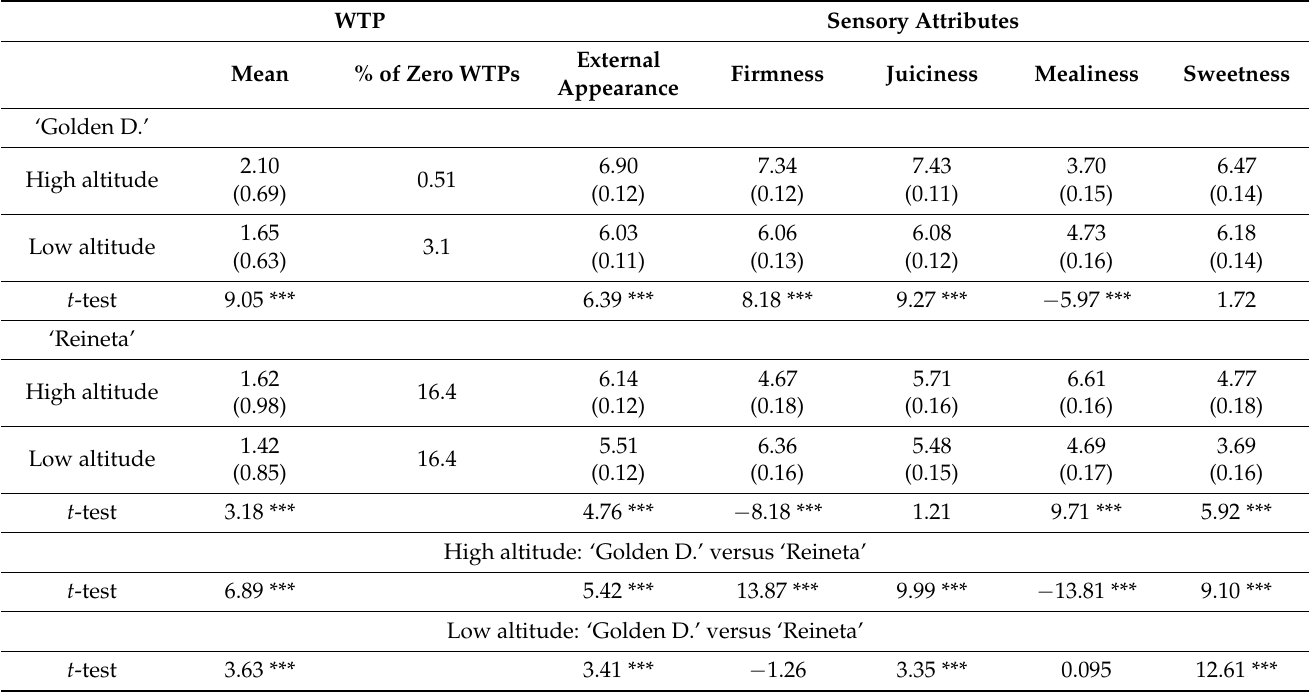
Table 2. Summary statistics and paired t -test values for pairwise comparisons of WTP and sensory attributes scores by growing altitude and apple